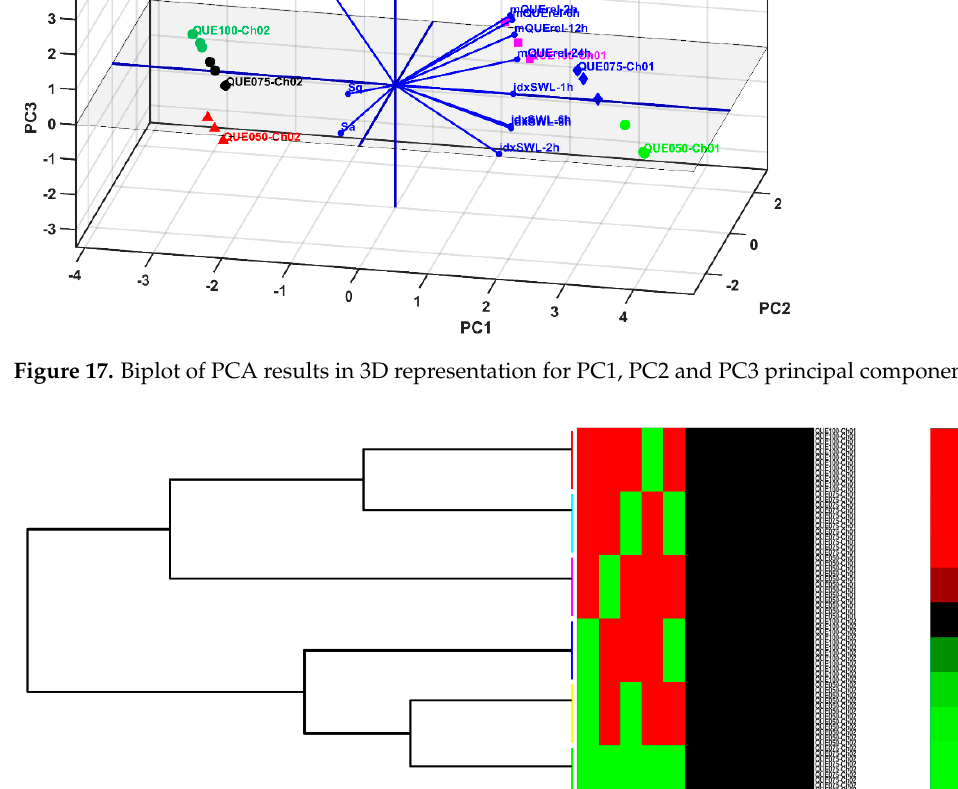
Figure 18. Cluster analysis of MANOVA ( p = 0.05) results: Heatmap representation for PC1 ÷ PC11 principal coordinates. Different colors for groupings of horizontal lines denotes a sample cluster.